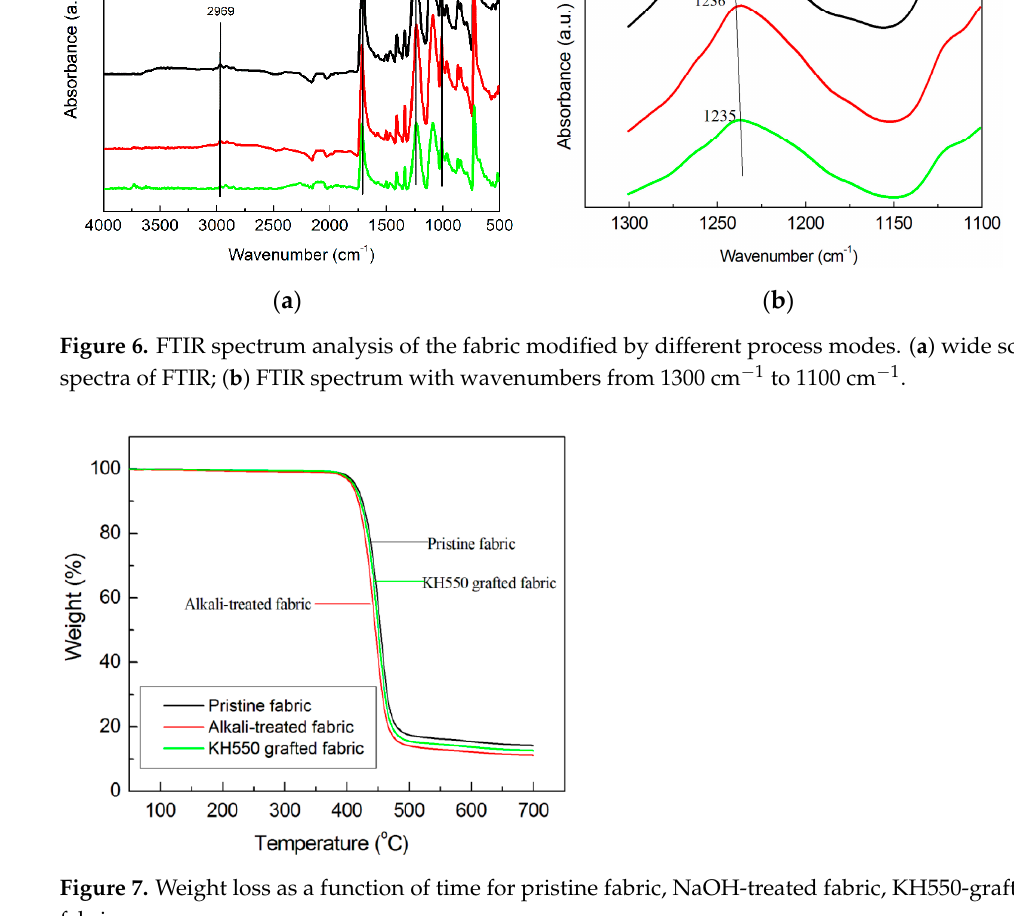
Figure 7. Weight loss as a function of time for pristine fabric, NaOH-treated fabric, KH550-grafted